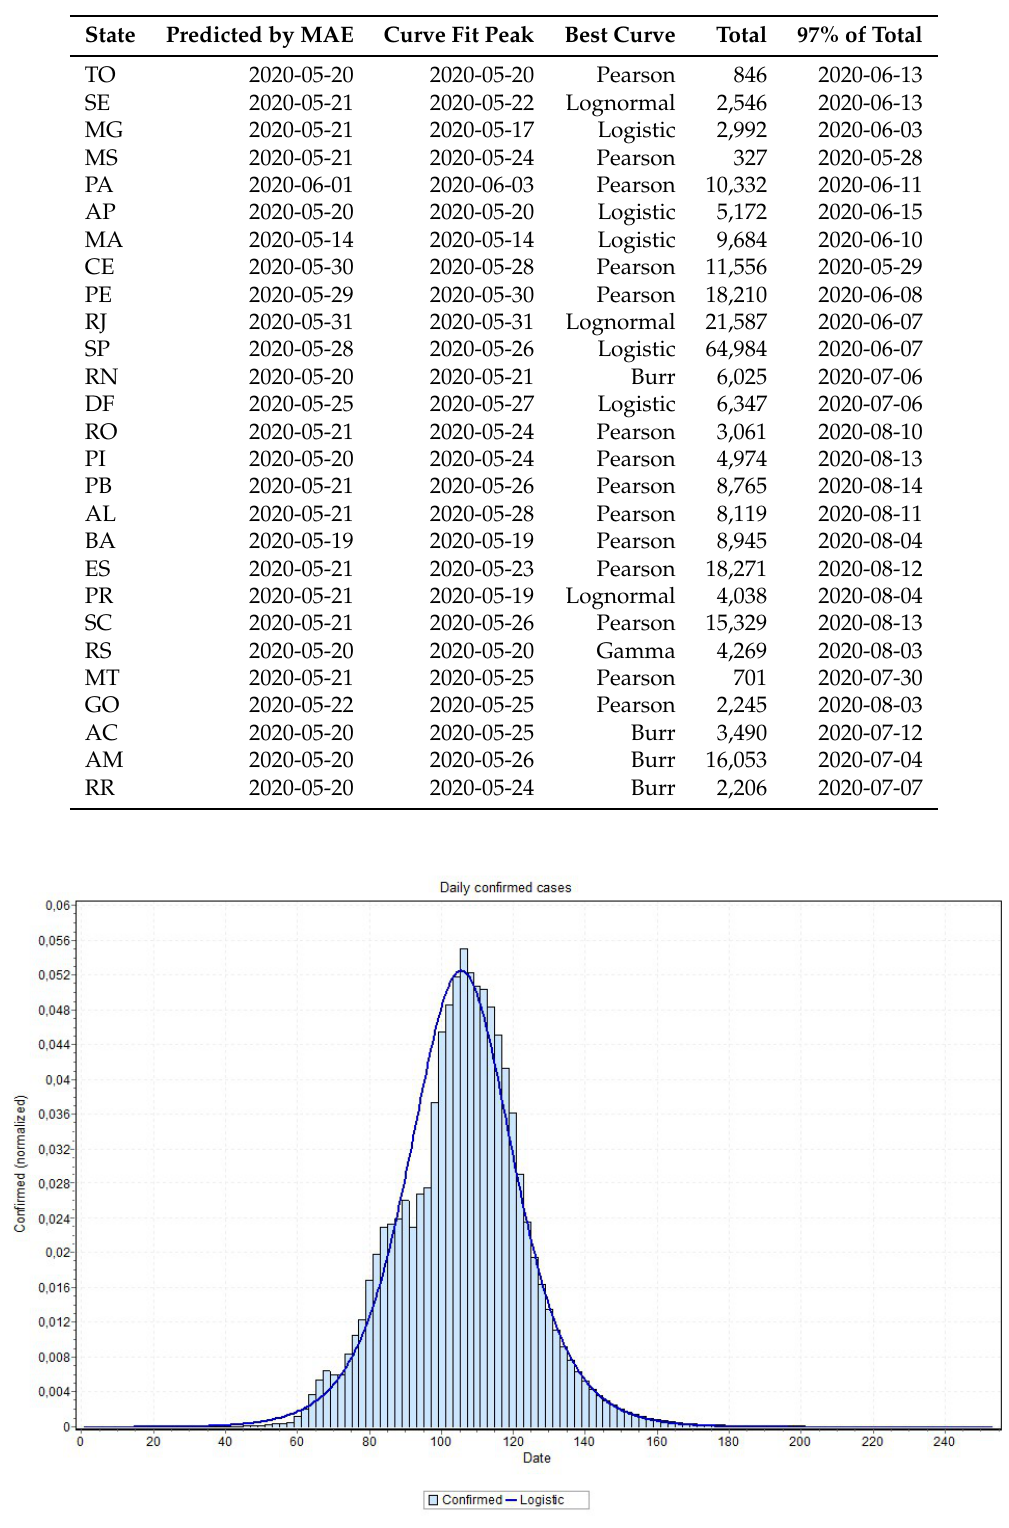
Table 2. Peak occurrences for each state predicted by the MAE Model and by a distribution probability. We also indicate the total number of cases expected by the MAE prediction and the day that it will reach 97% of the total number of cases.